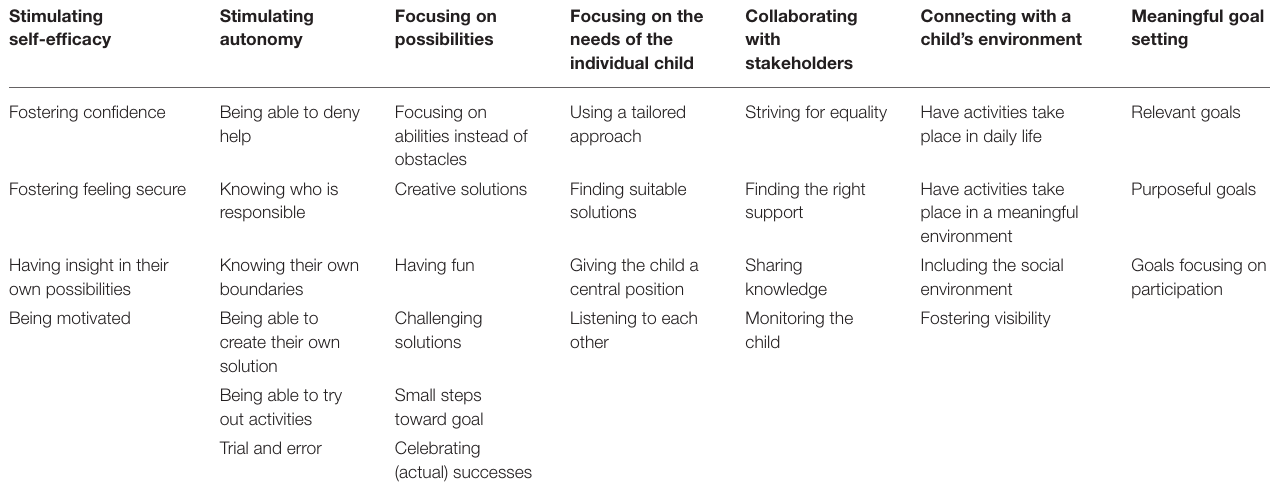
TABLE 1 | Themes and